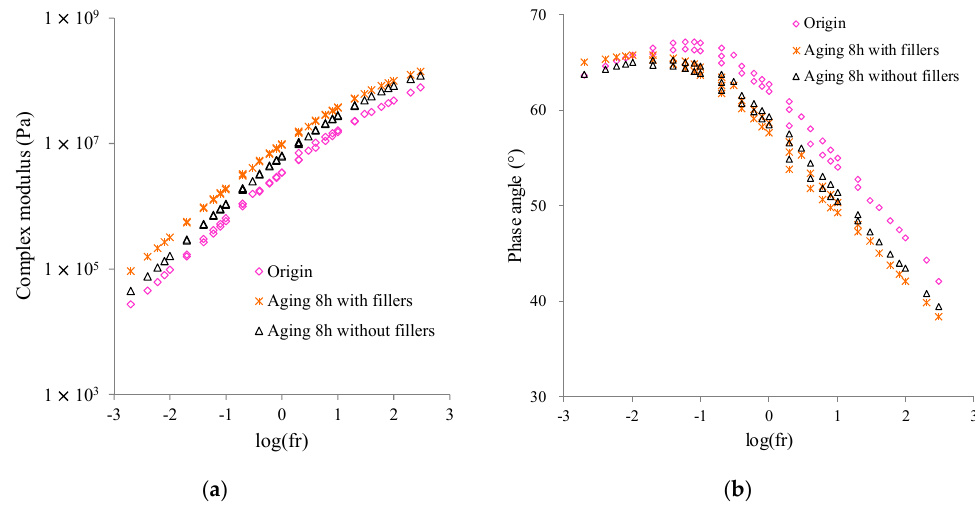
Figure 5. Master-curve of the mastics with filler content of 80% after aging 8 h with or without the fillers: ( a ) complex modulus; ( b ) phase angle.